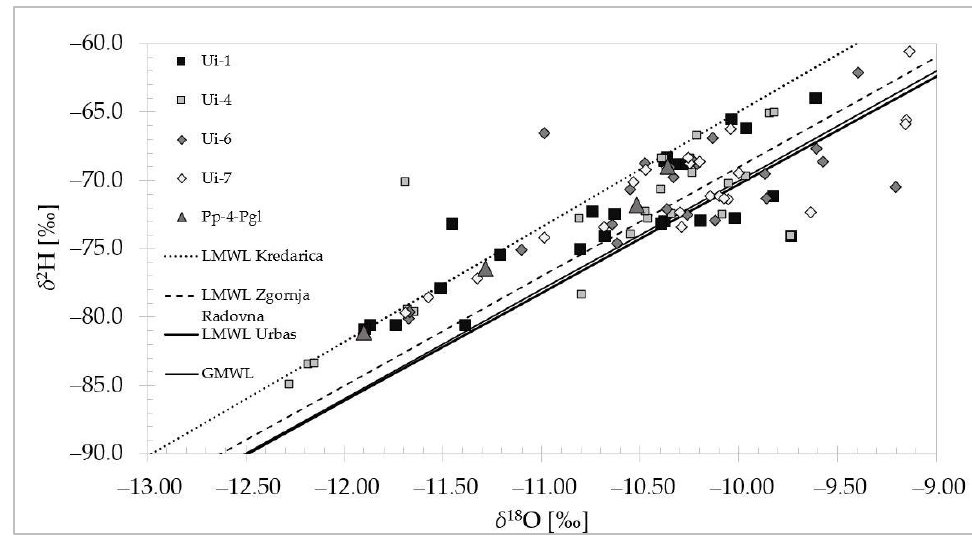
Figure 4. Comparison of the LMWL of Urbas with the LMWL of Kredarica and Zgornja Radovna. In 2018, snow cover at Javorniški Rovt was present till 7 April in 2019 until 7 May and 2020 till 3 April [30]. The investigated area was influenced by air masses of different origins that caused noticeable spatial and seasonal variability in the meteorological parameters [74].